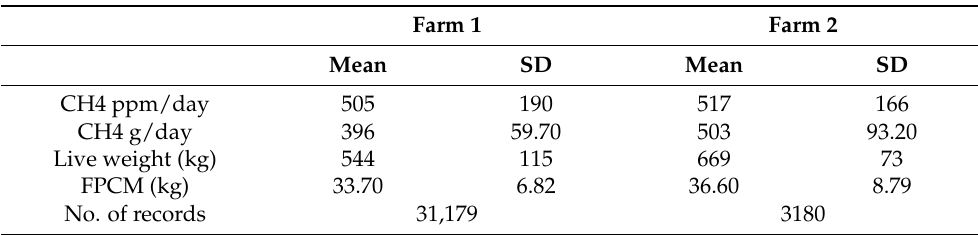
Table 1. Average CH 4 measurements, live weight, fat–protein corrected milk (FPCM) and number of records per